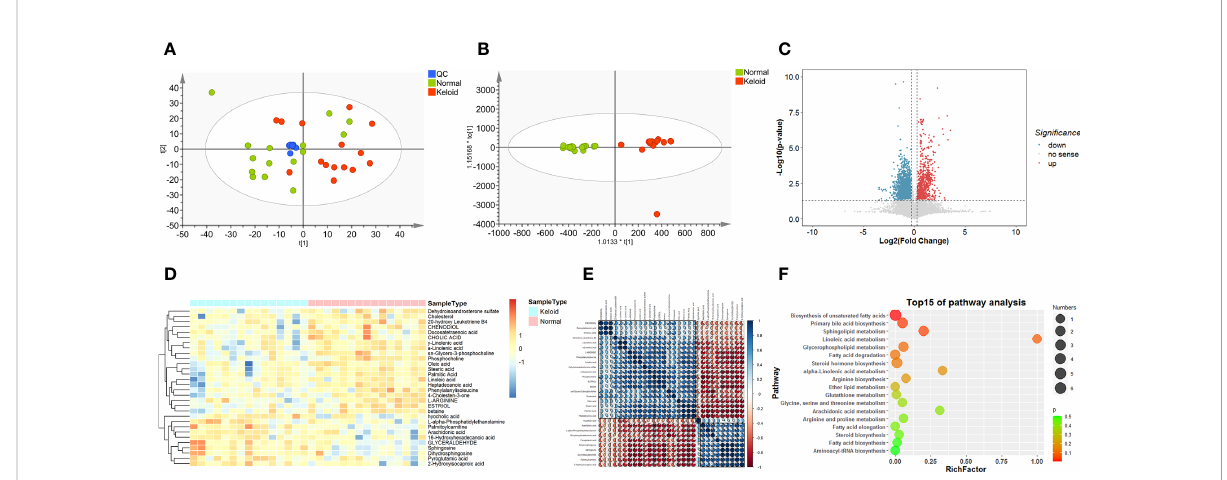
FIGURE 3 Metabolic pro fi ling of keloid by mass spectrometry-based untargeted metabolomics analysis. (A, B) PCA and OPLS-DA score plots for control (green), keloid (red), and QC (blue) samples in ESI+ and ESI- models. (C) Volcano plot of differentially expressed metabolites between the keloid and control samples. (FC > 1.2, P < 0.05) Red dots indicate that metabolites are up-regulated in keloid patients, whereas blue dots indicate down-regulation. (D) Heatmap of the relative abundance of the metabolites differentially expressed between the keloid and control groups. (E) Pearson ’ s correlation coef fi cient analysis shows the metabolic network among 30 signi fi cantly different metabolites. (F) Metabolic pathway analysis of differential expressed